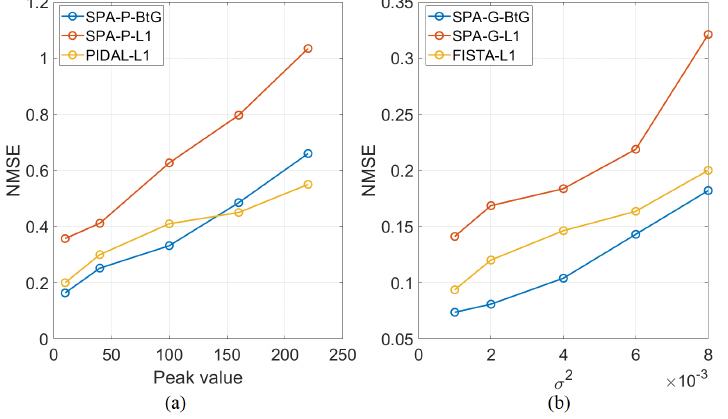
Figure 3. Normalized mean squared error (NMSE) plots for the ( a ) Poisson noise model with different peak values, ( b ) the Gaussian noise model when the maximum intensity is set to 220 and different noise variances.